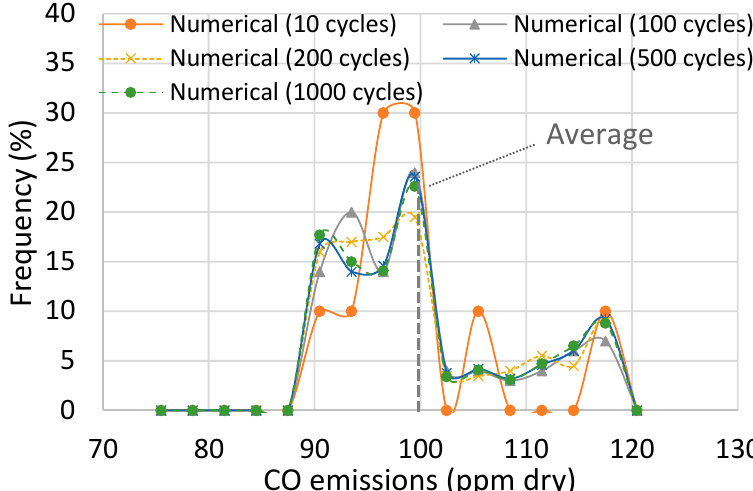
Figure 10. Frequency of CO emissions (dry) for a different number of cycles.